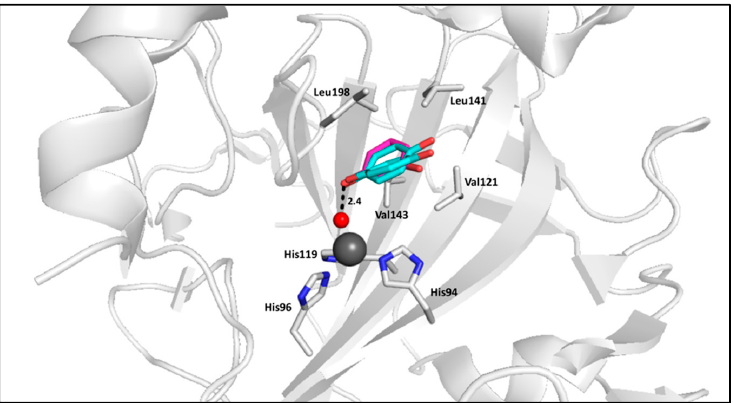
Figure 3. Phenol-based compounds benzene-1,4-diol ( cyan ) and resorcinol ( magenta ) in complex with CA ΙΙ ( gray ) (PDBs: 4E3H and 4E49, respectively)